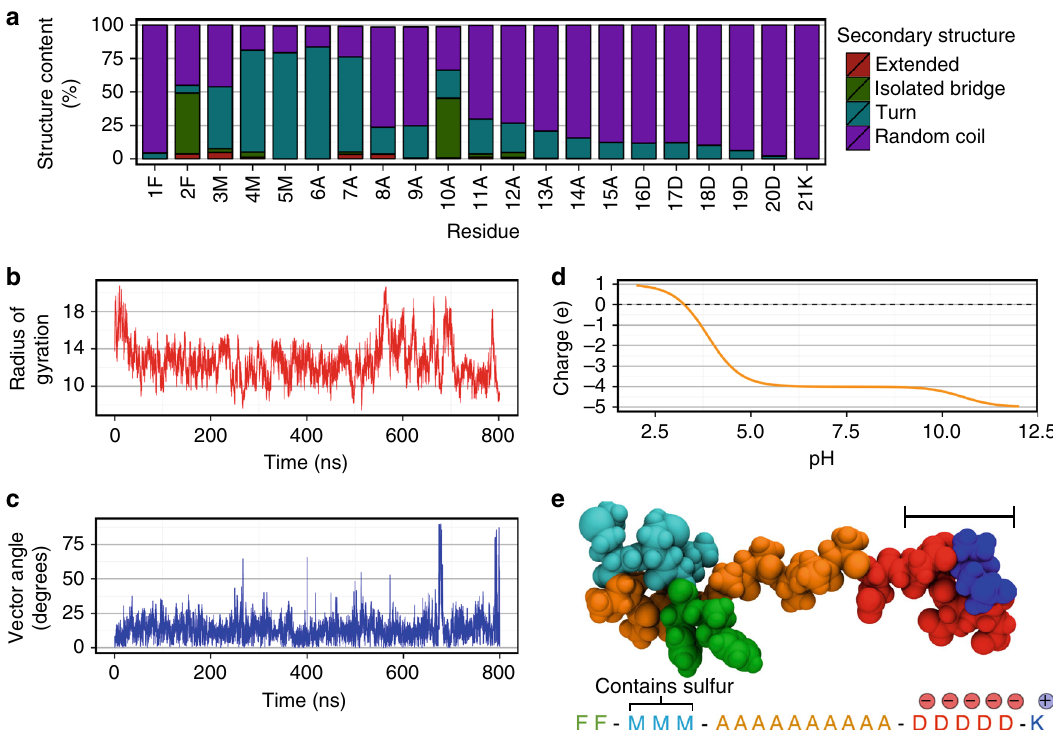
Fig. 3 The simulated peptide is linear and mostly unstructured. a Stacked bar chart labelled with amino acid one-letter codes showing the per-residue structure content that is mostly random coil. b The time series of R g shows that after 40 ns of equilibration, the peptide maintains a single length. c Time series of the vector angle between the fi rst principal axis and the dipole moment created by the charged residues. This shows that the dipole is closely aligned to the long axis of the peptide. d Net charge of the peptide across a range of pH values. All residues in the charged region are charged between approximately pH 5 – 10, leading to a net charge of − 4 e. e Space- fi lling model of a representative structure of the FLAG-tag peptide, showing the turn across residues F2 – A7, and the extended random coil structure of the polar, charged residues (D16 – K21). Scale bar: 1